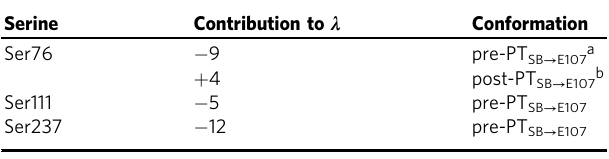
Fig. 2 Energetics of proton transfer in the H-bond network. a , b H-bond network of the Schiff base. c Potential energy pro fi le for proton transfer from the Schiff base to Glu107 in the ground-state structure of heliorhodopsin. d Potential energy pro fi le for proton transfer from Glu107 to His80. Purple, blue, and red curved lines in ( c ) and ( d ) correspond to the purple, blue, and red arrows in ( a ). Table 1 Contributions of serine residues to the absorption wavelength of the retinal Schiff base ( λ ) in